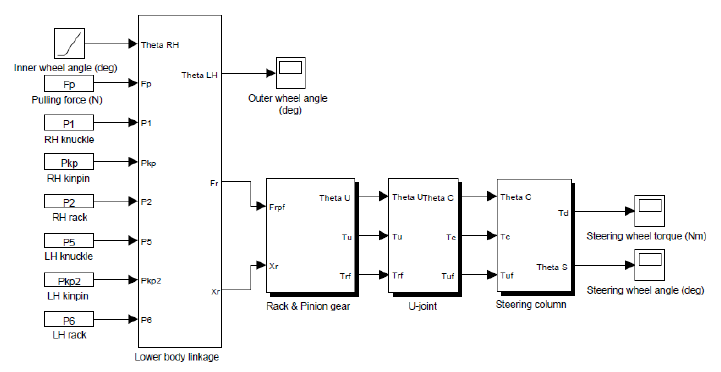
Figure 6. Steering system model.